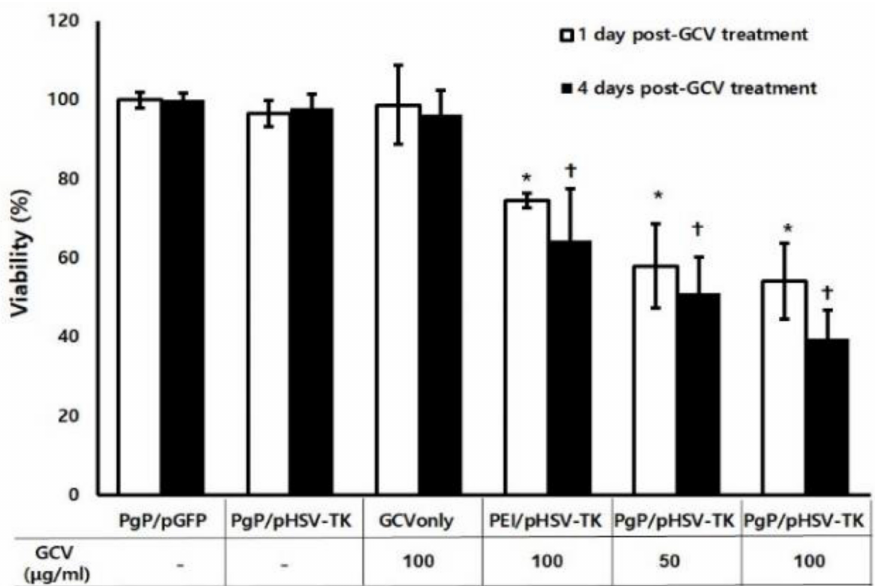
Figure 4. The suicide e ff ect of PgP / pHSV-TK polyplexes and GCV. C6 cells were transfected with PgP / pHSV-TK (2 µ g pHSV-TK) and then treated with GCV (50 and 100 µ g / mL). At 1 and 4 days post-GCV treatment, anti-cancer e ffi cacy was analyzed by MTT assay. PgP / pGFP (N / P of 60 / 1), PgP / pTK (N / P ratio of 60 / 1), GCV only (100 µ g / mL), bPEI / pTK (N / P ratio of 5 / 1) with GCV (100 µ g / mL) were used for comparison. Data represent the mean ± SD. *: p < 0.05 compared to PgP / pGFP at 1 day post-GCV treatment and + : p < 0.05 compared to PgP / pGFP at 4 days post-GCV